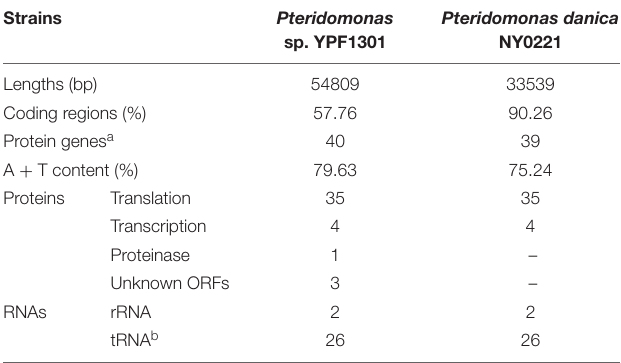
TABLE 1 | Plastid genomes of Pteridomonas